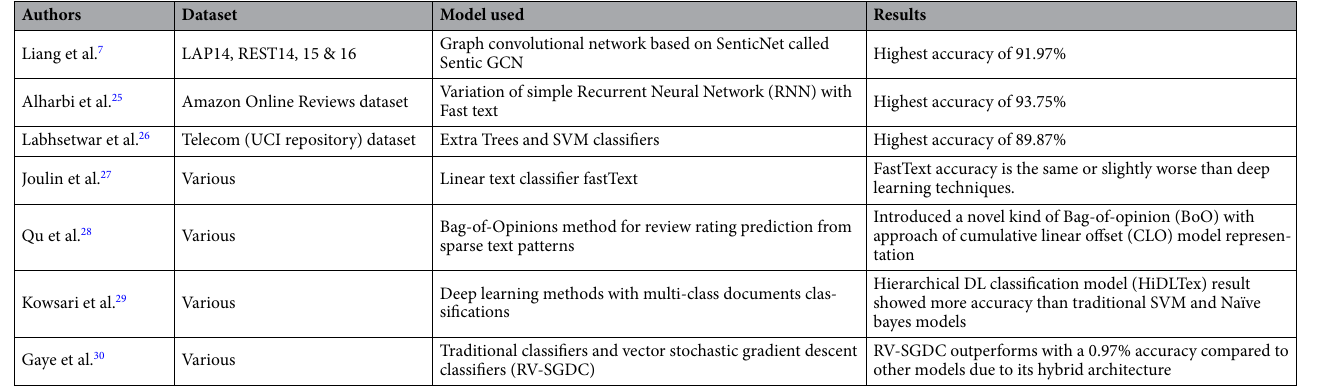
Table 1. Comparison of state-of-art methods for analyzing